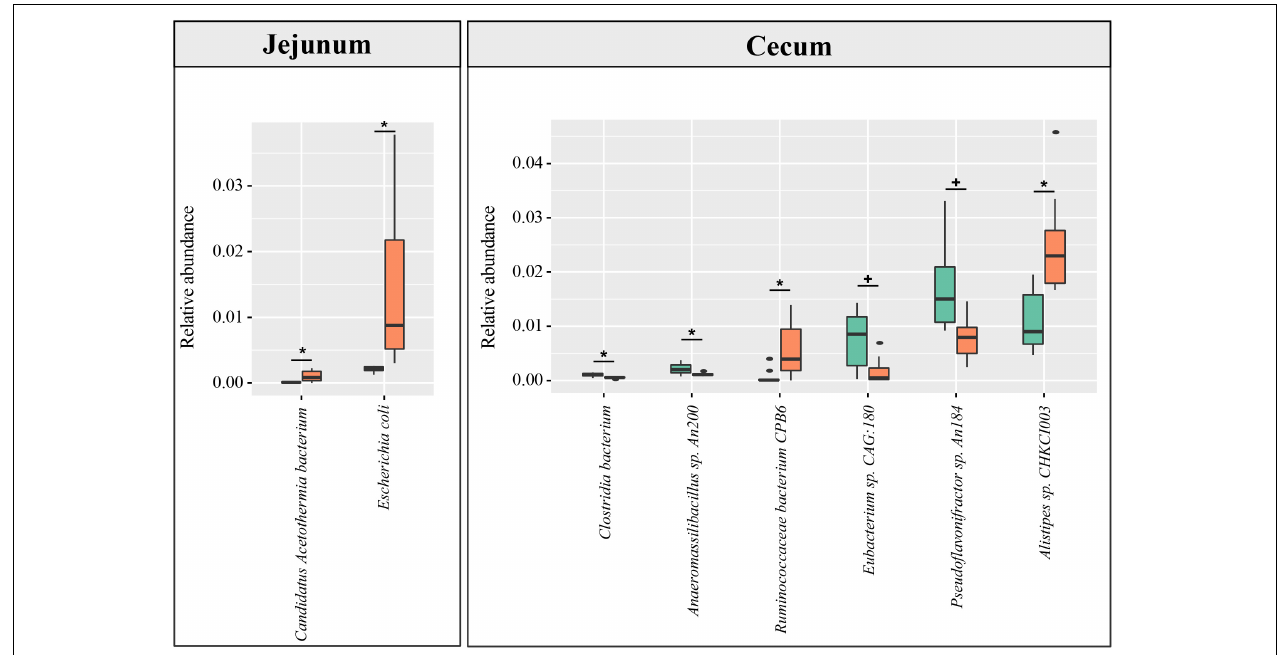
FIGURE 2 | The difference in species abundance between the lean- and fat-line broilers. Microbial species identified in all samples of at least one group with relative abundance over 0.1% were used to perform the differential comparison between the two lines. Metastats software was used, and species with FDR < 0.1 are shown in the figure. No differential species between the two broiler lines were identified in the duodenum and ileum. The green and orange columns stand for lean line and fat line, respectively. The green boxes stand for lean-line broilers, while the orange boxes stand for fat-line broilers. *FDR < 0.05; + 0.05 ≤ FDR <